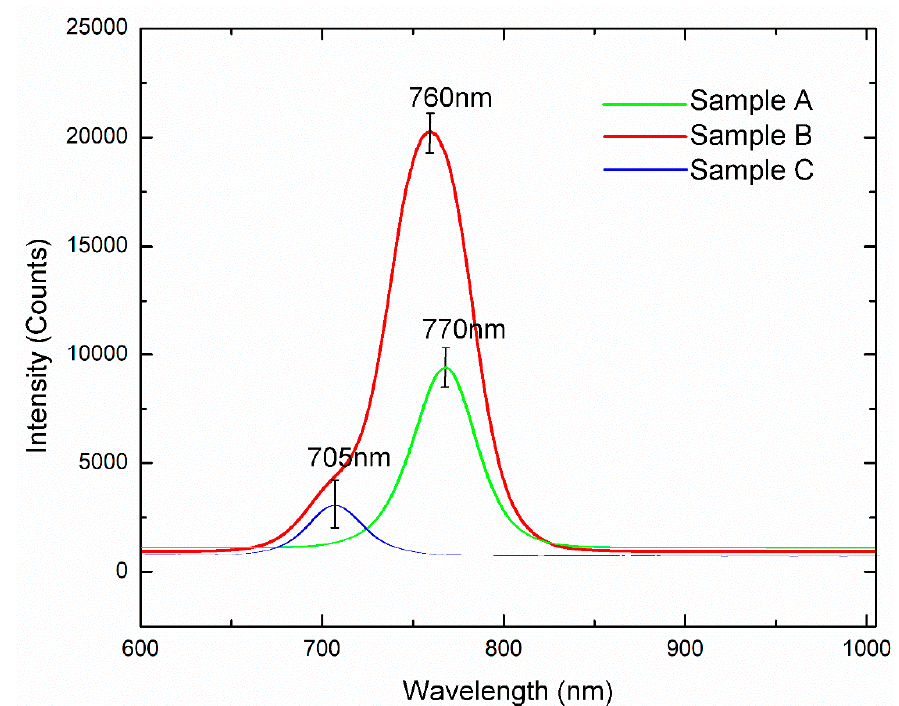
Figure 8. Photoluminescence results.